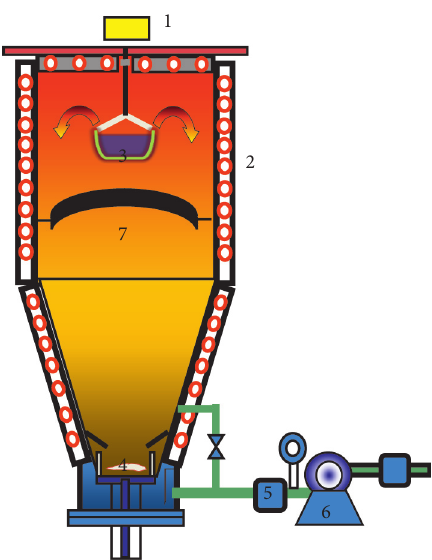
Figure 1: Experimental setup for the salt separation experiments (1: load cell, 2: heater, 3: uranium deposits, 4: recovered salt, 5: filter, 6: vacuum pump, and 7: heat